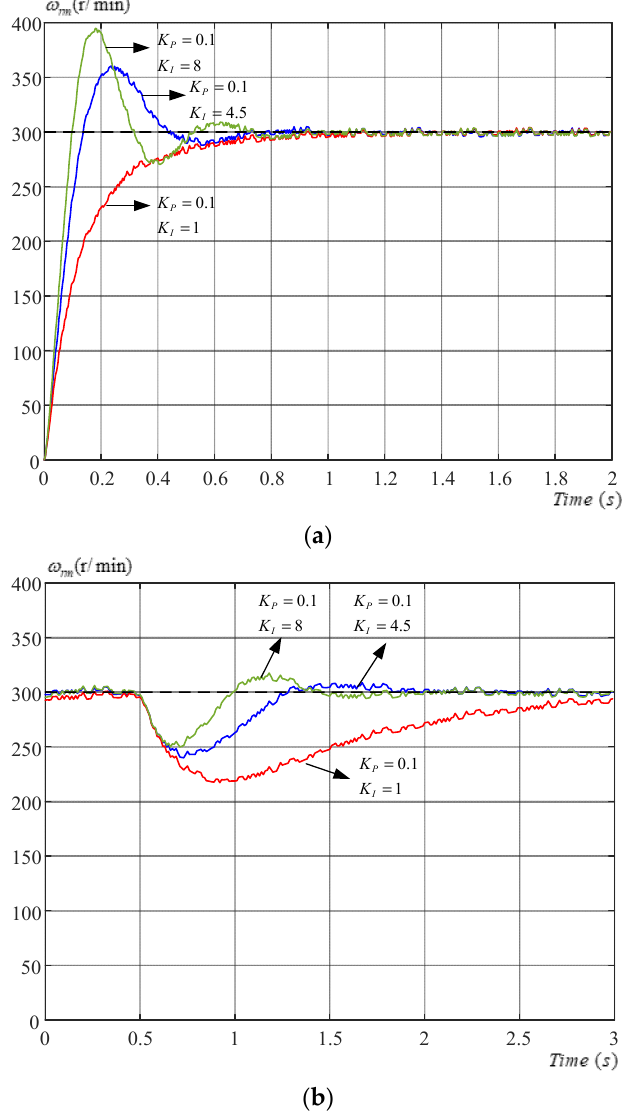
Figure 13. Measured speed responses with different proportional-integral (PI) control parameters. ( a ) Transient and ( b ) load disturbance.